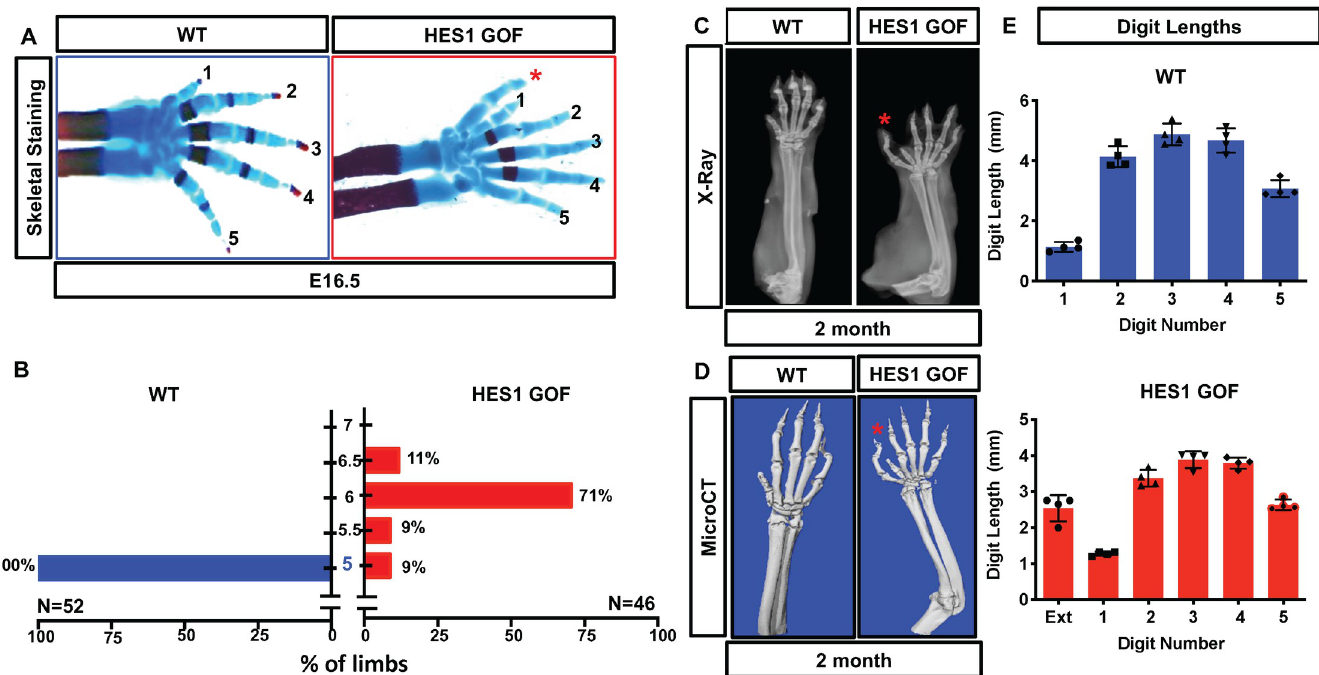
Fig 1. Hes1 over-expression within limb bud mesenchyme induces preaxial polydactyly. (A) Alcian Blue/Alizarin Red staining of WT and Prx1Cre;R26-Hes1 f/f (Hes1 GOF) mutant E16.5 forelimbs. Red asterisk indicates extra digit. (B) Quantification of digit numbers for WT (N = 52) and HES1 GOF (N = 46) forelimbs ( χ 2 test) (p- value < 0.0001). Y axis represents the number of digits whereas the x-axis represents the percent of the forelimbs. Intervals of 0.5 represent syndactylous digits ( S1 Fig ). (C-D) Representative X-ray and MicroCT images of 2-month old WT and HES1 GOF forelimbs. Red asterisks indicate the extra digit (N = 4) (E) Digit length analysis of WT and HES1 GOF at 2-months of age (N =